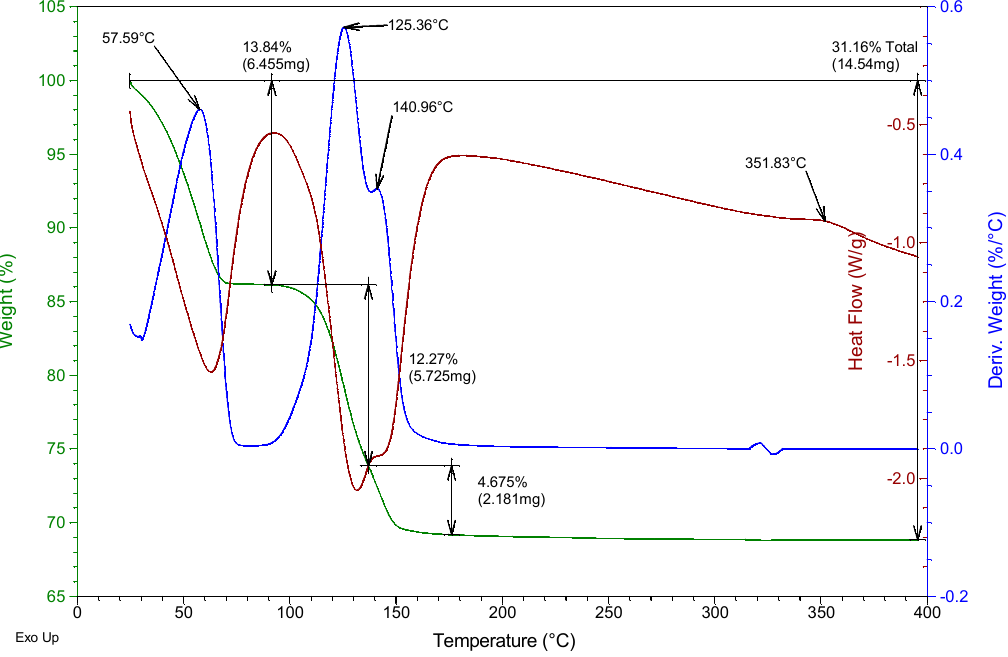
Figure 9. Thermogravimetric analysis of the test tube E35-0.7 aged 1 day.